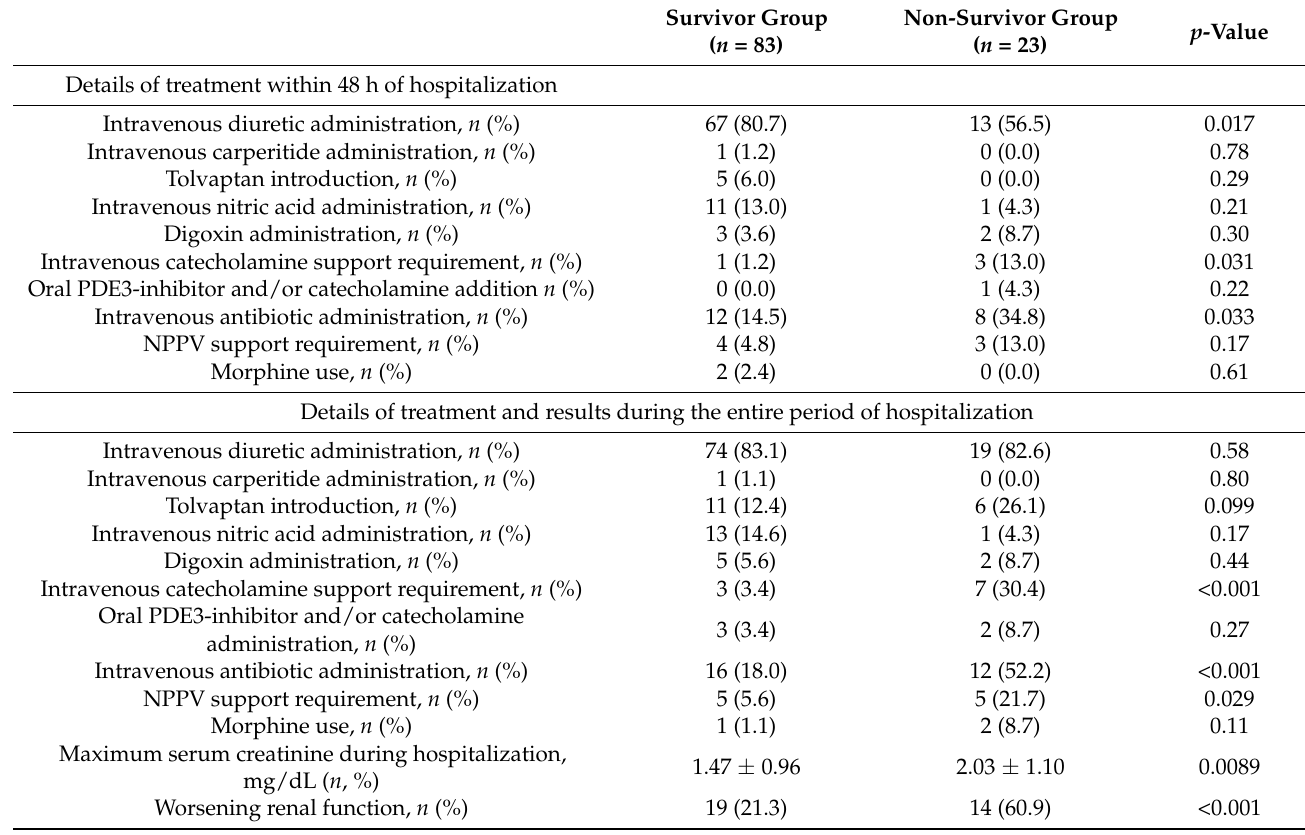
Table 3. Comparison of treatment and outcomes during hospitalization between the survivor and non-survivor groups. Survivor Group